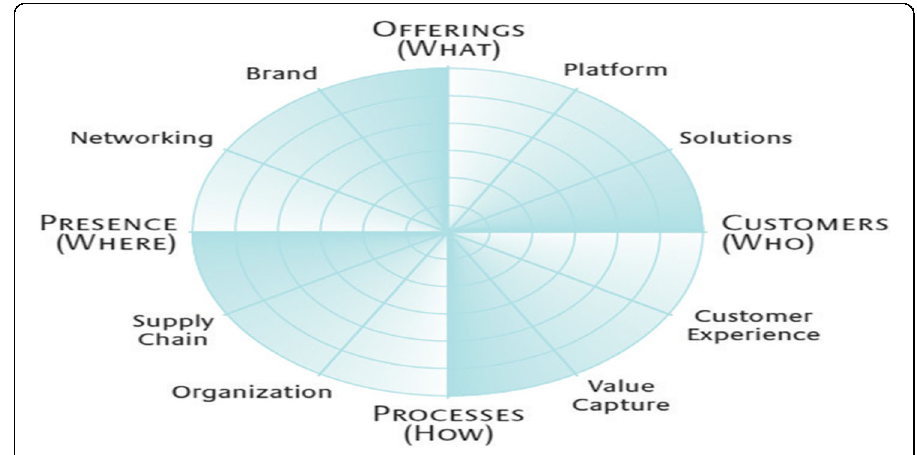
Fig. 4 Innovation radar. Source (Solis et al., 2014, Speranza,